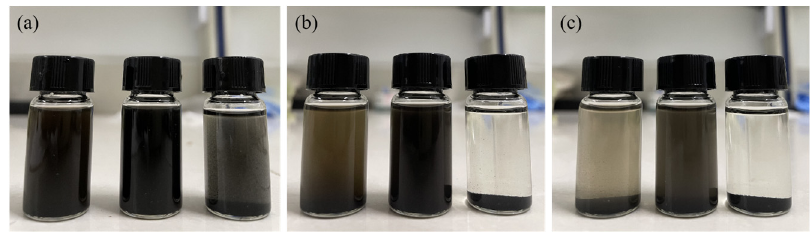
Figure 6. ( a ) Original dispersion; ( b ) Dispersion after 6h standing; ( c ) Dispersion after 24h